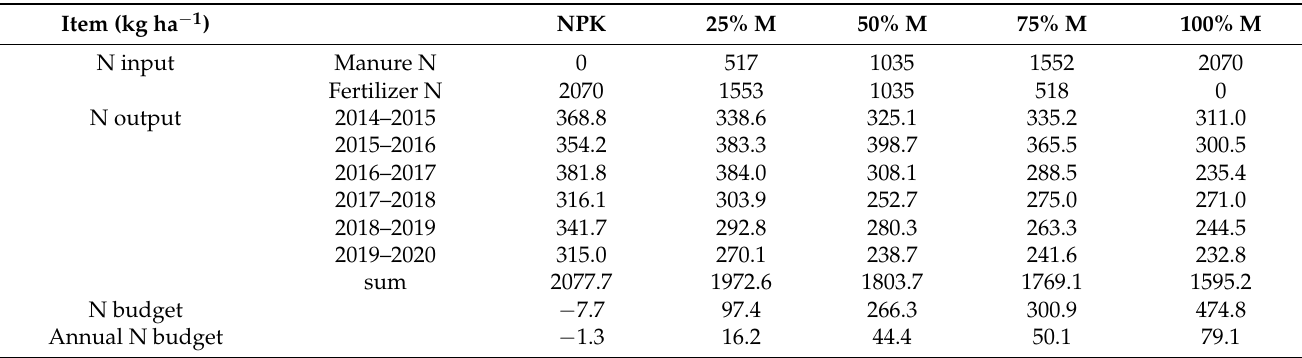
Table 3. Apparent nitrogen balance of winter wheat–summer maize cropping system under different fertilization treatments during 2014–2020.